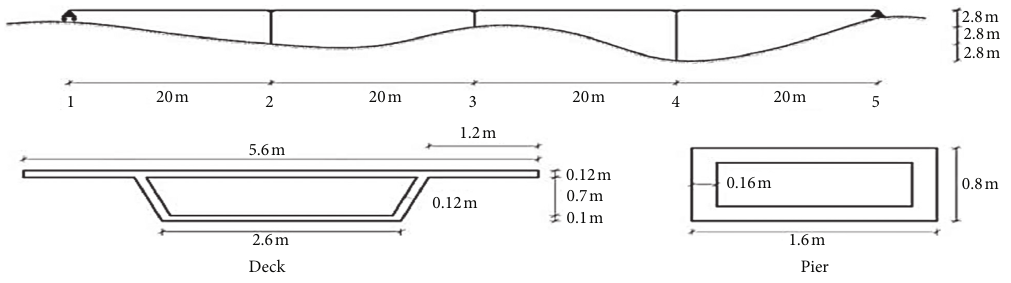
Figure 5: Layout of the bridge structural elements [7].